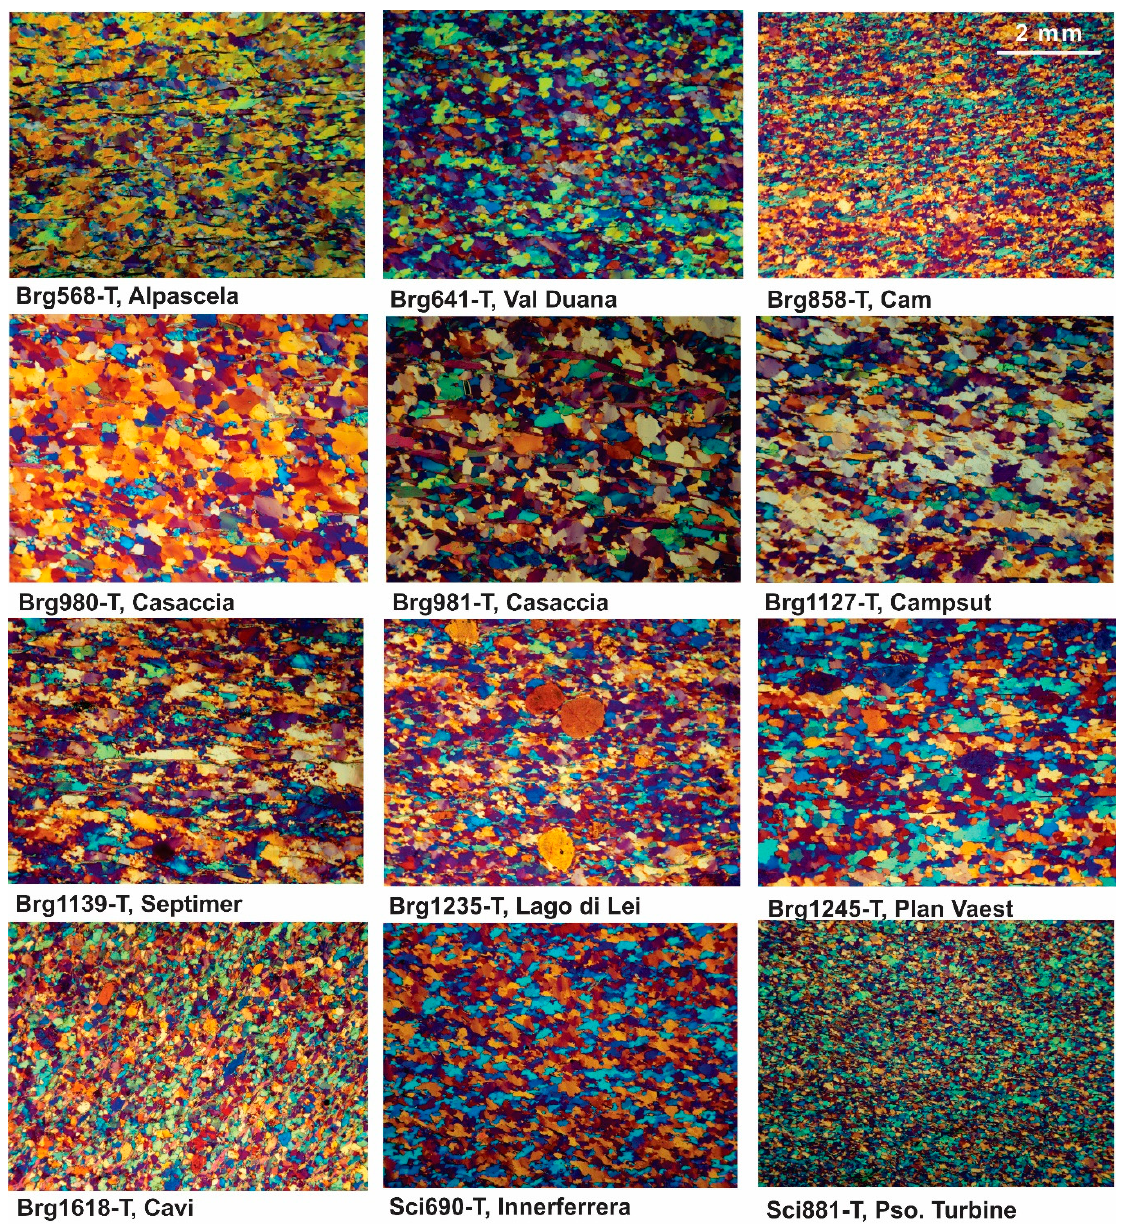
Figure 3. Optical images of thin sections from selected Triassic quartzites. Crossed polarizers, gypsum plate inserted to highlight orientation differences. Scale indicated at top right. For more images with crossed polarizers only see Supplementary Material Figure S1. Order of samples is the same as in